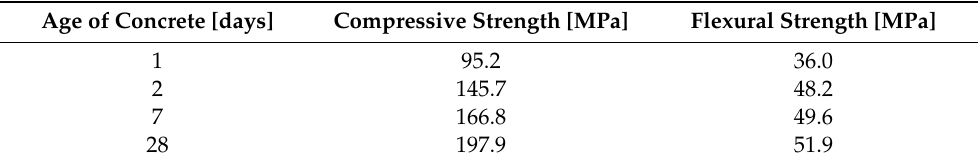
Table 3. Results of compressive and flexural strength tests of the RPC.